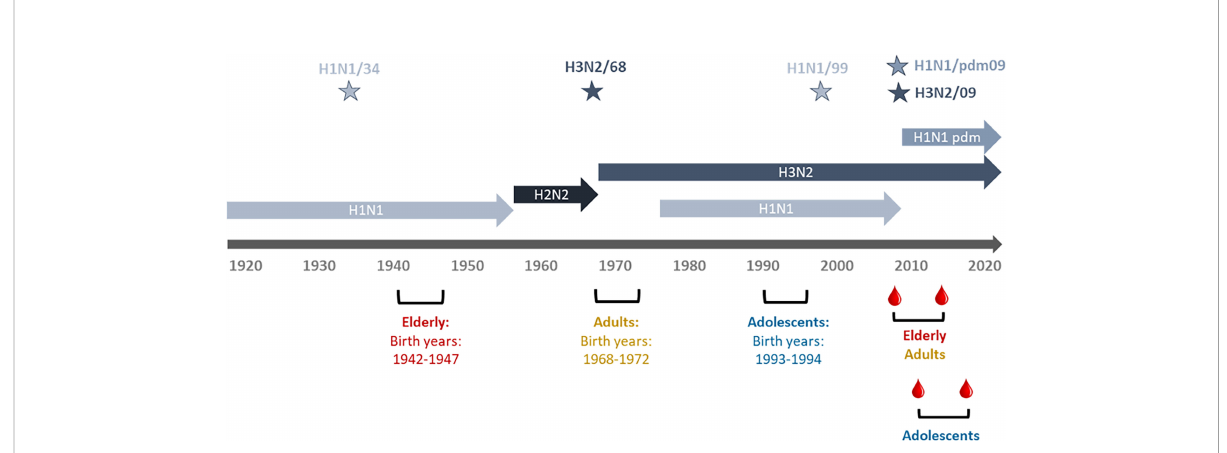
FIGURE 1 Timeline of IAV circulation, cohort birth dates, and sampling period. Depicted are the different in fl uenza virus subtypes and the periods during which they were circulating. Stars denote the virus strains used in this study (H1N1/34: A/Puerto Rico/8/34, H3N2/68: A/Aichi/1/68, H1N1/99: A/ New Caledonia/20/99, H1H1pdm09: A/California/7/2009, H3N2/09: A/Perth/16/2009. The birth periods of the study cohorts are shown in red for the elderly, in green for the adults and in ochre brown for the adolescents. Dates of blood sampling are indicated for the adults and elderly and for the adolescents.